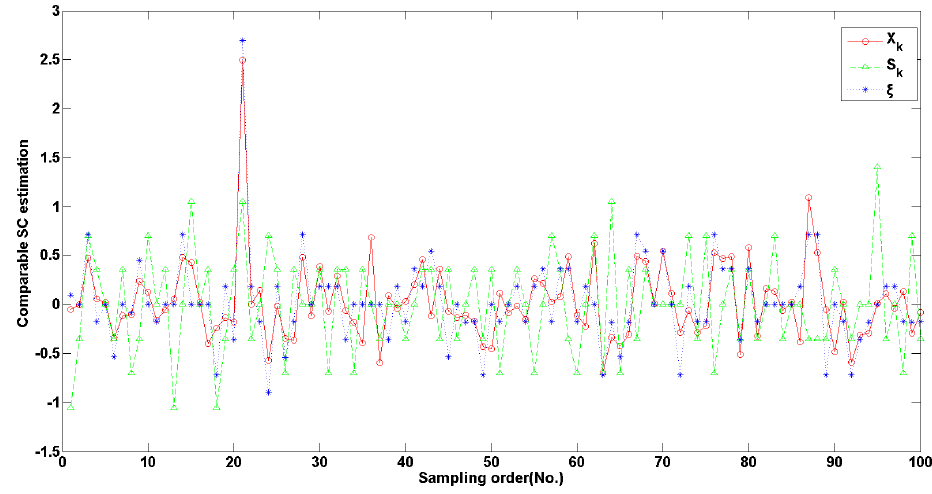
Figure 8. Comparison between KF for the γ -ray sensor.